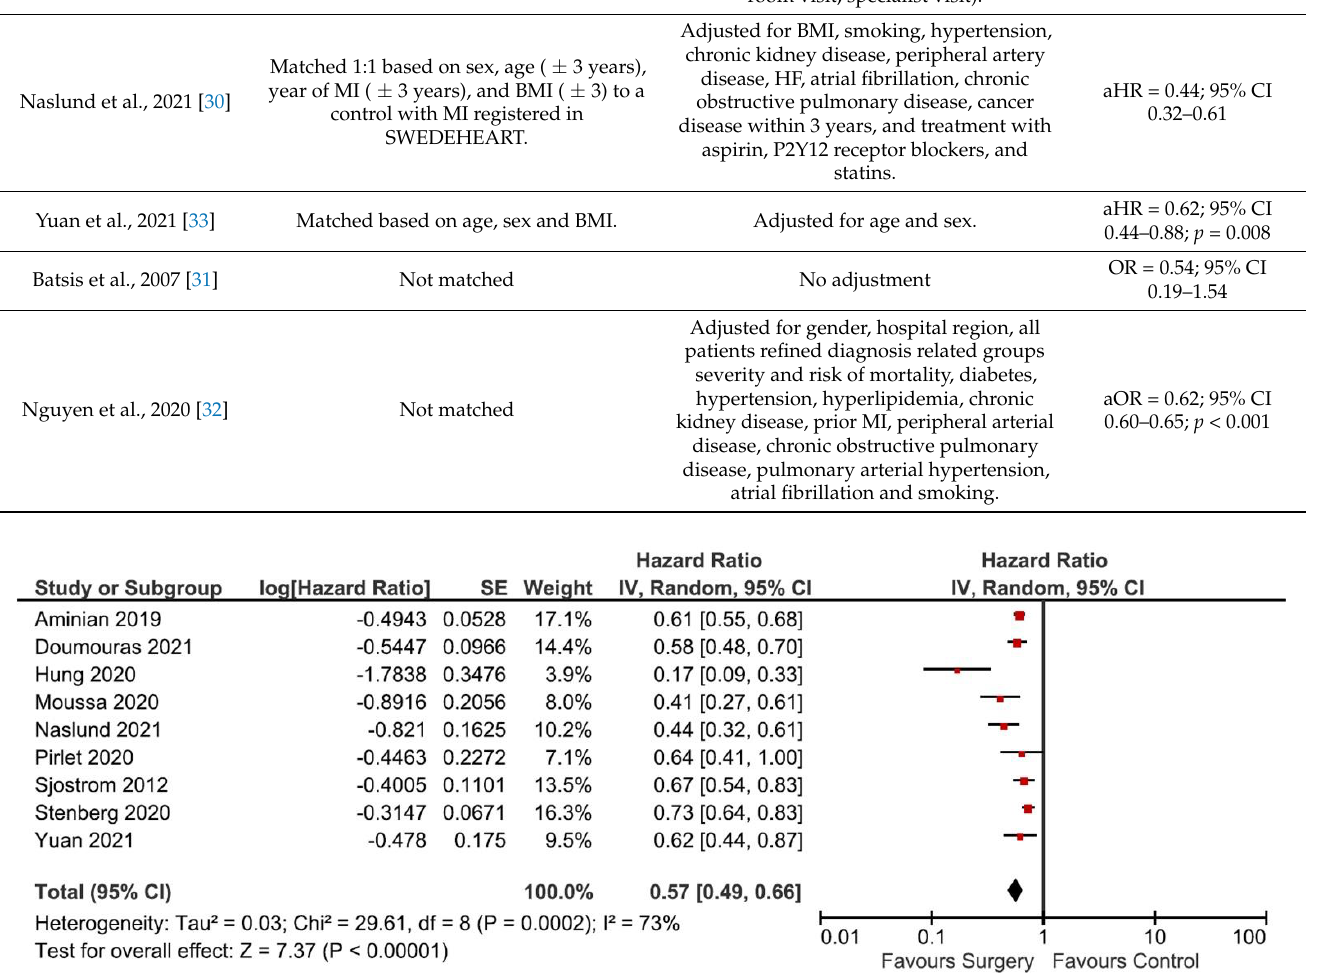
Figure 7. Adjusted forest plot of the MACE incidence comparing bariatric surgery with no surgery.